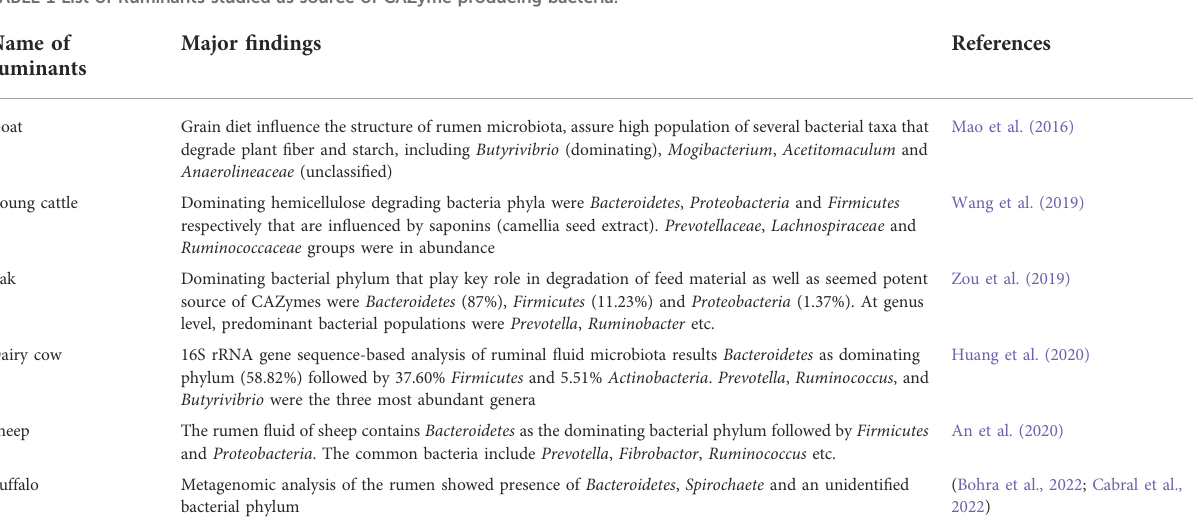
TABLE 1 List of Ruminants studied as source of CAZyme producing